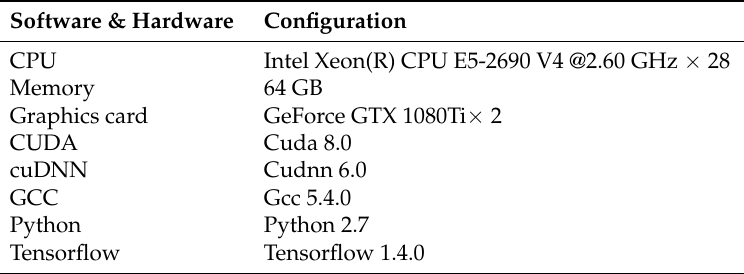
Table 2. Types of activities to